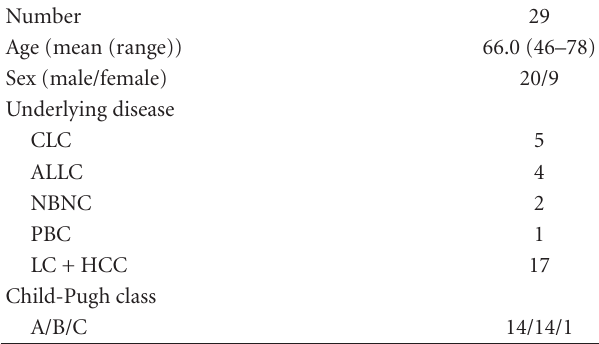
Table 2: Patients’ background. ALLC, alcoholic liver cirrhosis; CLC, HCV-related liver cirrhosis; HCC, hepatocellular carcinoma; LC, liver cirrhosis NBNC, non-B, non-C liver cirrhosis; PBC, primary biliary